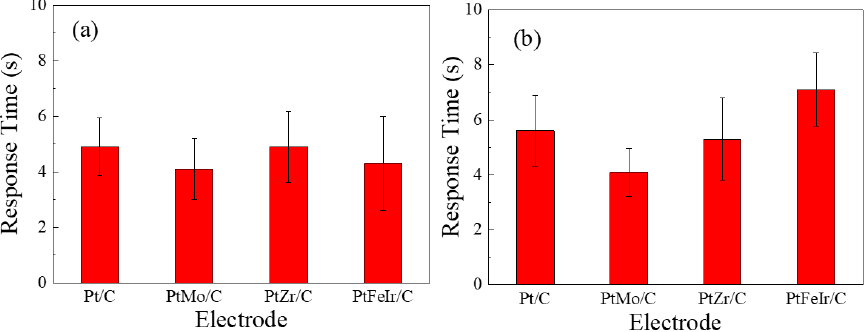
Figure 8. Response time for the detection of ( a ) AA; and ( b ) DA for the Pt/C/GCE, Pt-Mo/C/GCE, Pt-Zr/C/GCE and Pt-Fe-Ir/C/GCE. Pt-Zr/C/GCE and